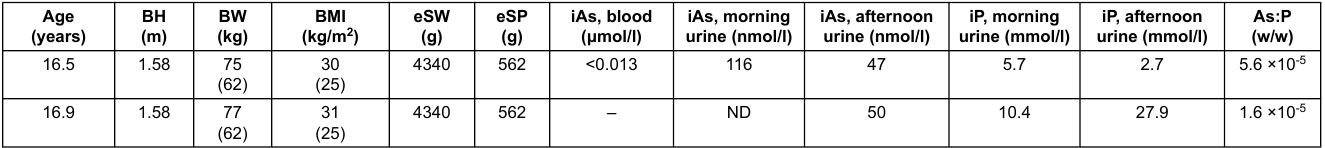
– ND BH = body height; BW = body weight (between brackets: ideal weight considering the patient’s large body frame); BMI = body mass index; eSW = estimated skeleton dry weight; eSP = estimated skeleton P-content; iAs = inorganic arsenic; iP = inorganic phosphorus. ND = non-detectable. Figures are rounded-up. See methods section for